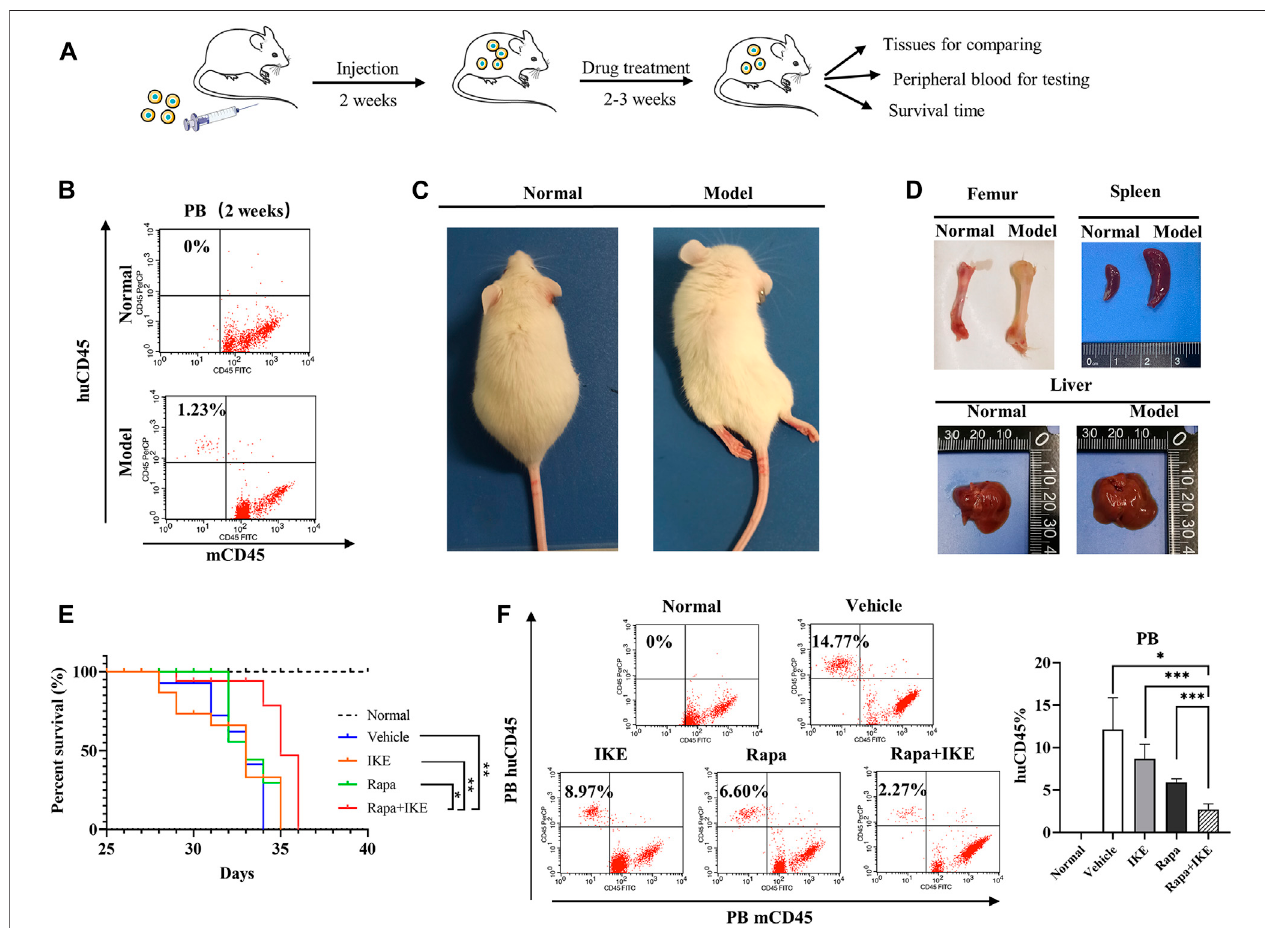
FIGURE 5 | Effect of the combination of rapamycin and erastin in vivo . NOD/SCID mice were injected with 5 × 10 6 CCRF-CEM cells (in 200 µl). Mice were treated withvehicle(2%DMSO+30%PEG300+68%normalsaline),Rapa(2 mg/kg),IKE(20 mg/kg),andRapa(2 mg/kg)+IKE(20 mg/kg)onweek2aftertransplantation( n (cid:1) 8/group). (A) Schematic overview of in vivo drug treatment. (B) Flow cytometric detection of human ALL cells (huCD45 + mCD45 – ) in peripheral blood of mice engrafted with ALL cells (week 2). (C) Morphological changes in engrafted mice. (D) Representative photographs of livers and spleens from mice engrafted with CCRF-CEM cells after 4 weeks. (E) Survival curve of mice with different treatments. (F) Flow cytometric detection of human ALL cells (huCD45 + mCD45 – ) in peripheral blood of engraftedmicefollowingdifferenttreatments.Left,percentagesofleukemiccells(huCD45 + mCD45 – )intheperipheralbloodofmice;right,histogramofresults.* p < 0.05, ** p < 0.01, *** p <